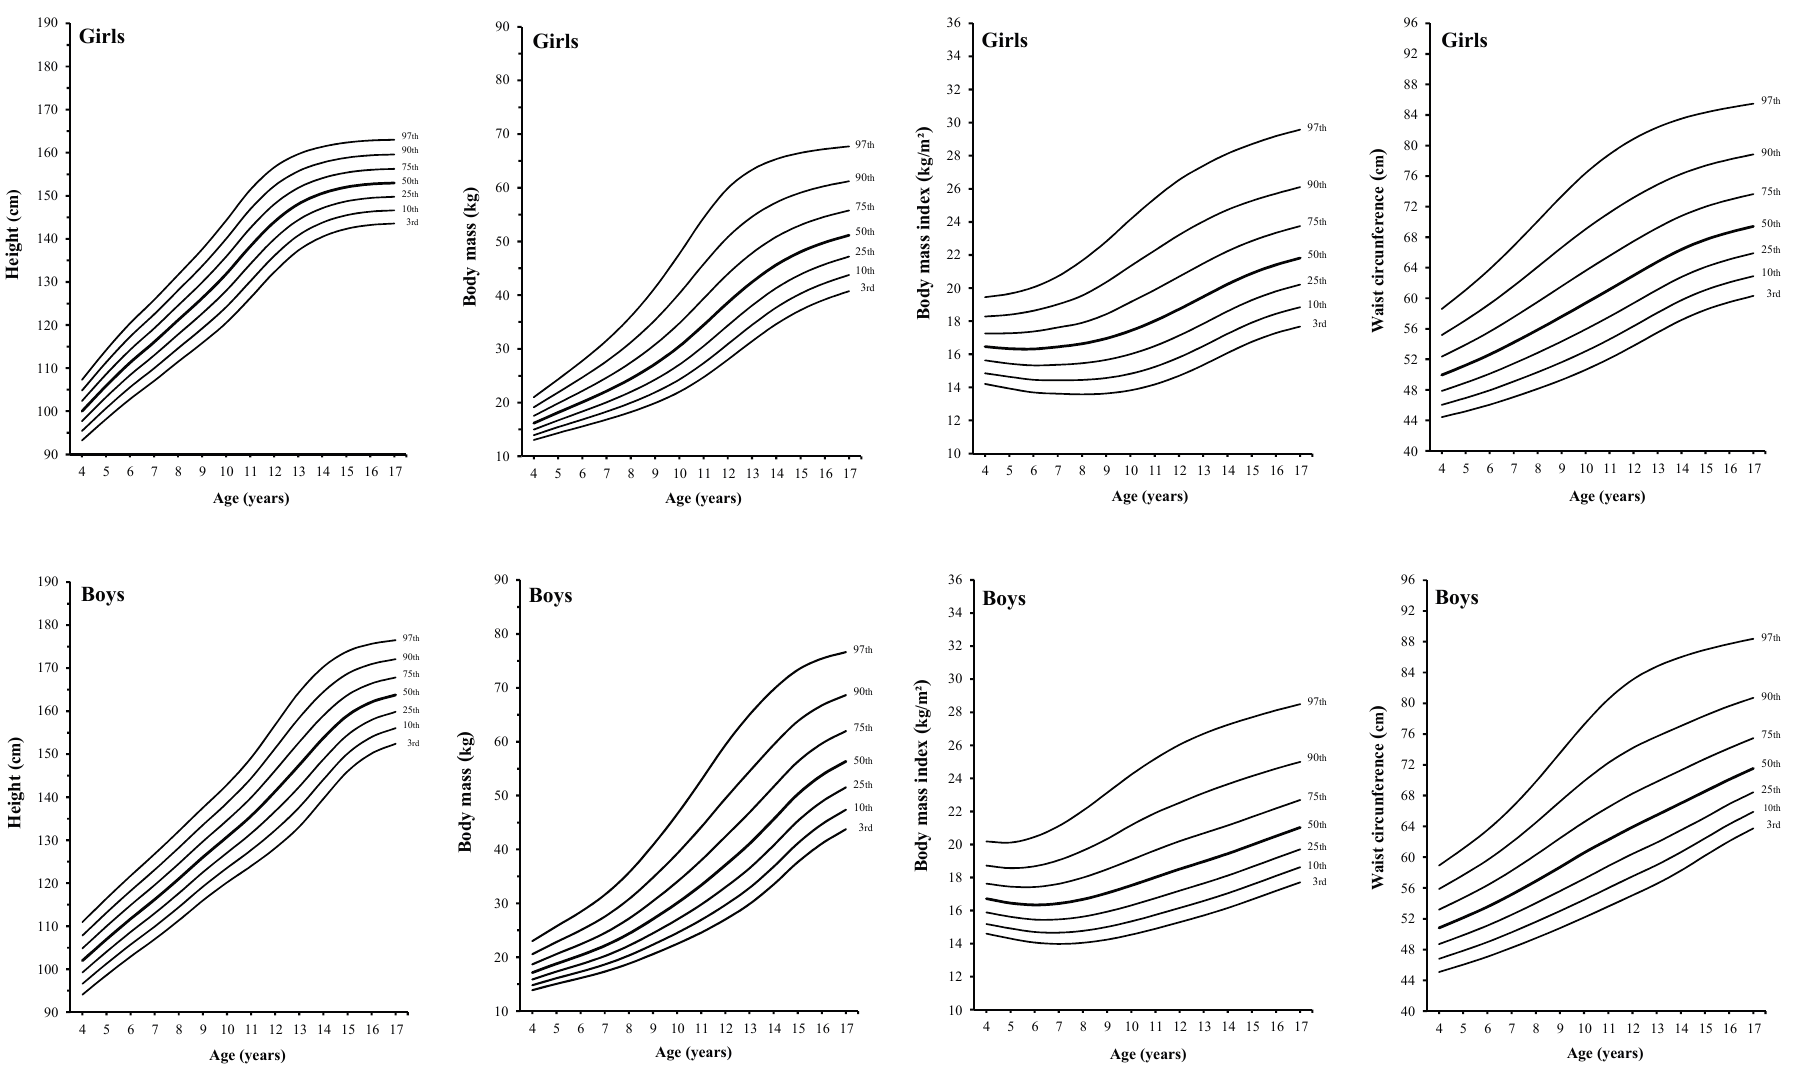
Figure 2. Smoothed reference curves for the 3rd, 10th, 25th, 50th, 75th, 90th and 97th percentiles for height, body mass, body mass index and waist circumference in 4 to 17 year-old Peruvian boys and